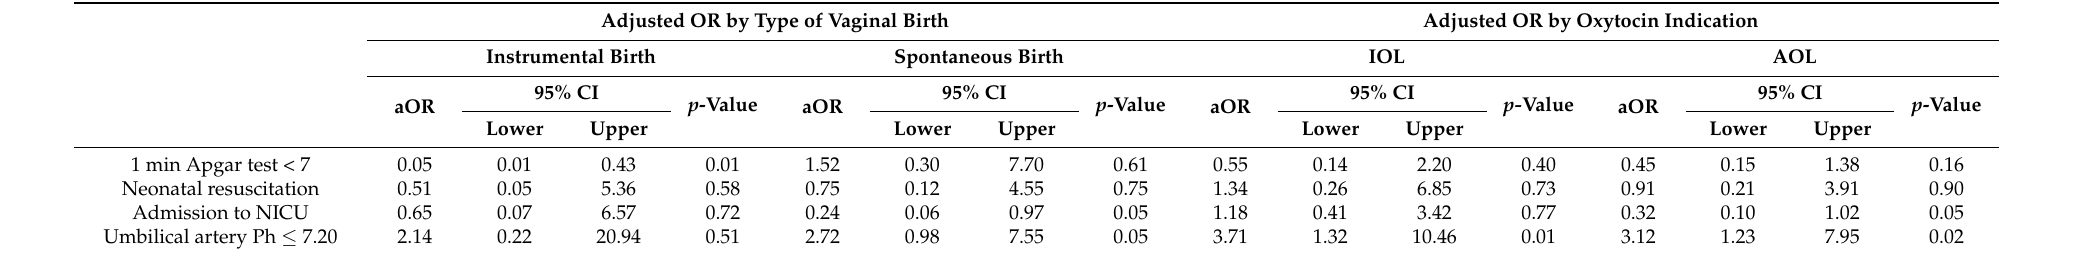
Table 4. Crude and adjusted OR for neonatal outcomes with oxytocin as a predictor by type of vaginal birth and oxytocin indication. Adjusted OR by Type of Vaginal Birth Adjusted OR by Oxytocin Indication Instrumental Birth Spontaneous